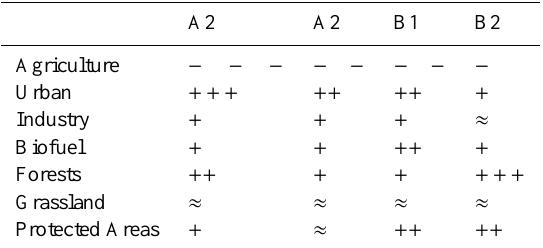
Table 3. Main trends in land use changes in the SRES for Europe.